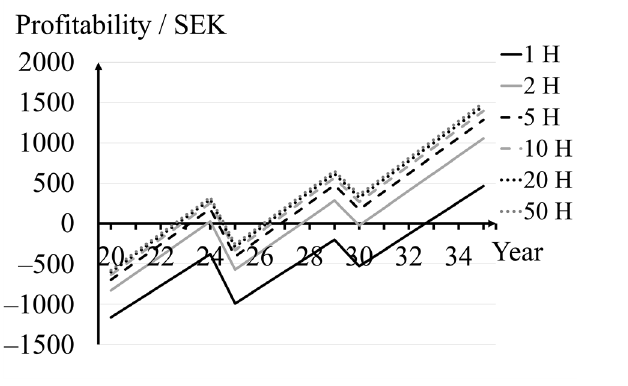
( b ) Figure 10. ( a ) Average payback in different combinations with different PV systems considering an electricity price growth of 2%; ( b ) average payback in different combinations with different PV sys- tems considering an electricity price growth of 3%. In Figure 11a,b, average household profitability was analysed over the years to ex- plain the difference in payback reduction between different scenarios of electricity price growth. In the analysis, the payback is represented by the year when the PV system be- comes profitable for the first time. Recurrent costs such as the change of the inverter in the 30th year (Figure 11a,b) and the change of the module in the 25th year (Figure 11b) cause financial losses. Given that, more time is needed for a PV system to become profitable. It was observed for an individual PV system (1H) with an electricity price growth of 2% (Figure 11a) that profitability drops in the 30th year when the inverter is exchanged. After